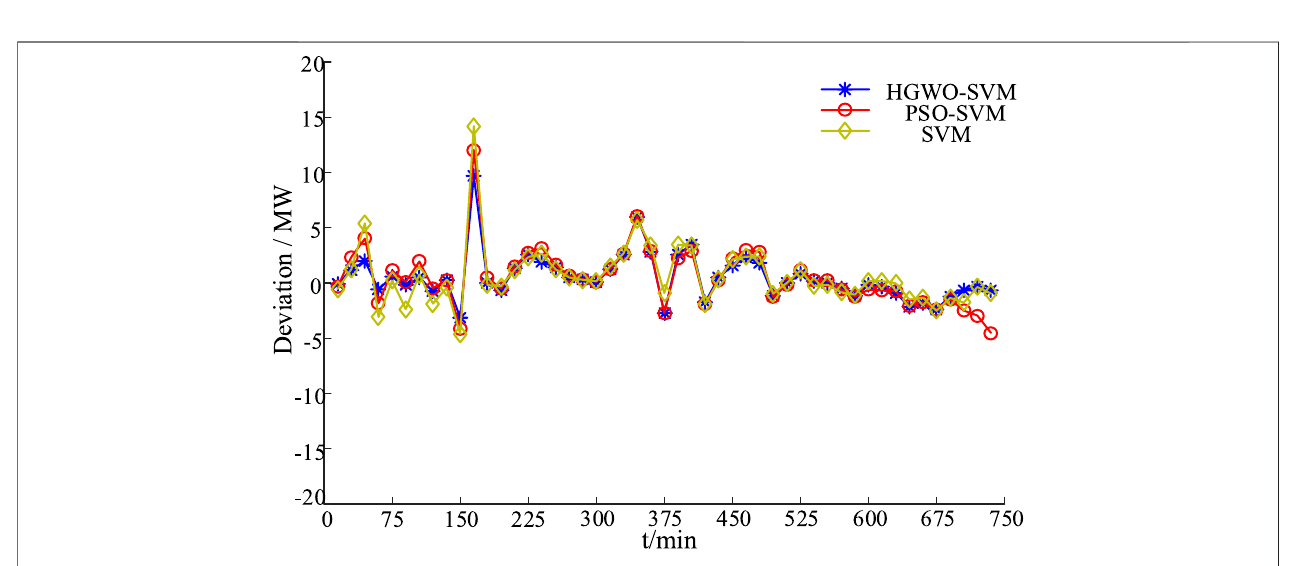
FIGURE 7 | Comparison of multi-method output prediction deviation.